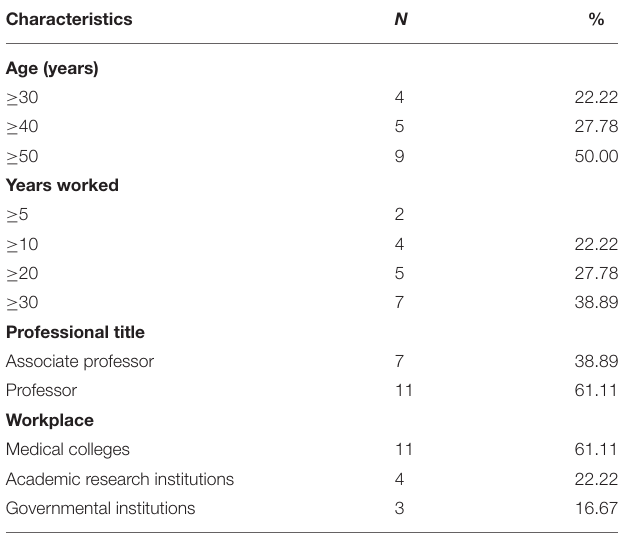
TABLE 3 | Profile characteristics of the experts ( n =